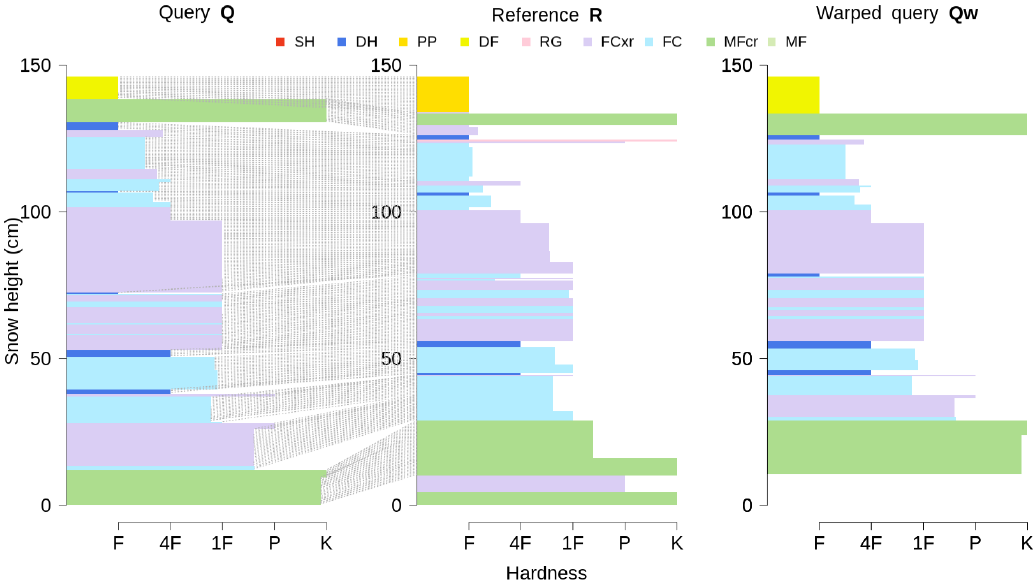
Figure 3. The open-begin alignment of two snow profiles Q and R : the line segments match the corresponding layers between Q and R . Adjusting the layer thicknesses of profile Q yields the warped profile Q w , which is optimally aligned to profile R